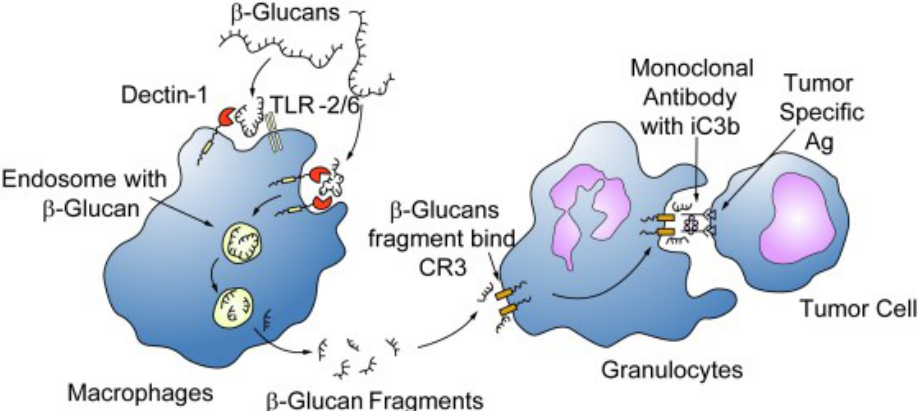
Figure 2. Schematic effect of β -glucans on immune and cancer cells. β -glucans are captured by the macrophages via the Dectin-1 receptor with or without TLR-2/6, internalized, fragmented into smaller fragments, carried to the marrow and endothelial reticular system and subsequently released. These small β -glucan fragments are eventually taken up by circulating granulocytes, monocytes or macrophages via the complement receptor (CR)3 and the immune responses turned include phagocytosis of the monoclonal antibody tagged tumor cells. From [37] with permission.